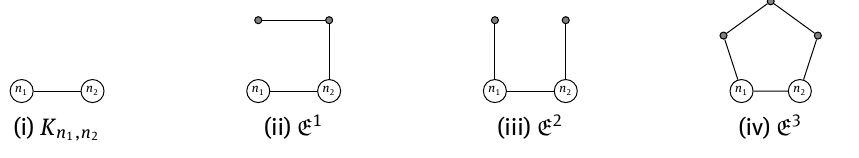
Figure 3: The family of graphs E with clique number 2. A white vertex represents a stable set of cardinality n v and a gray vertex represents a single